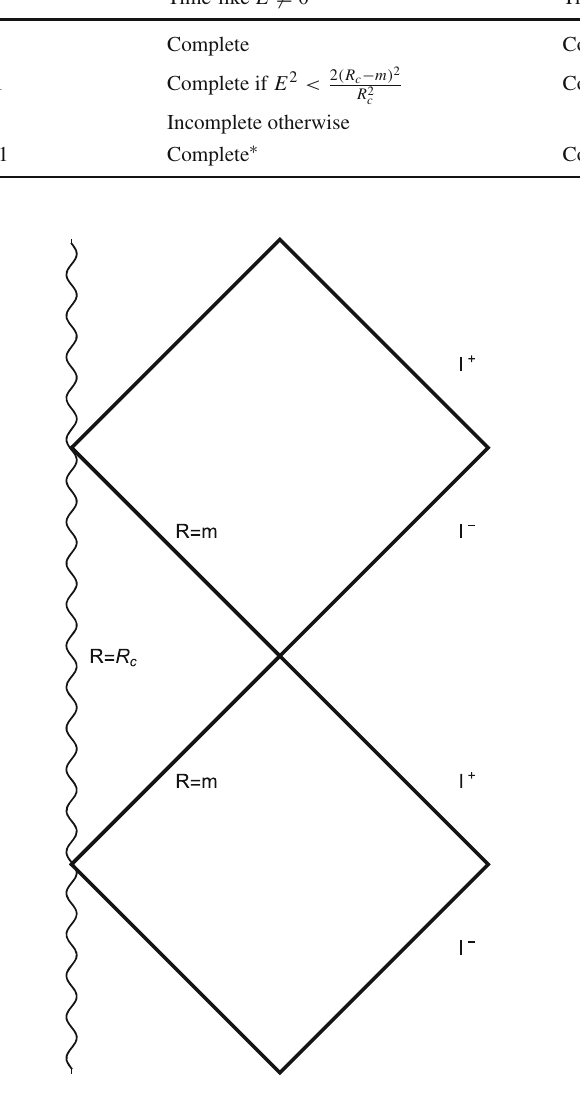
Fig. 4 Conformal diagram of the case m > R c when s = + 1. The diagram repeats itself in the vertical axis indefinitely. The wavy line represents the location of curvature divergences